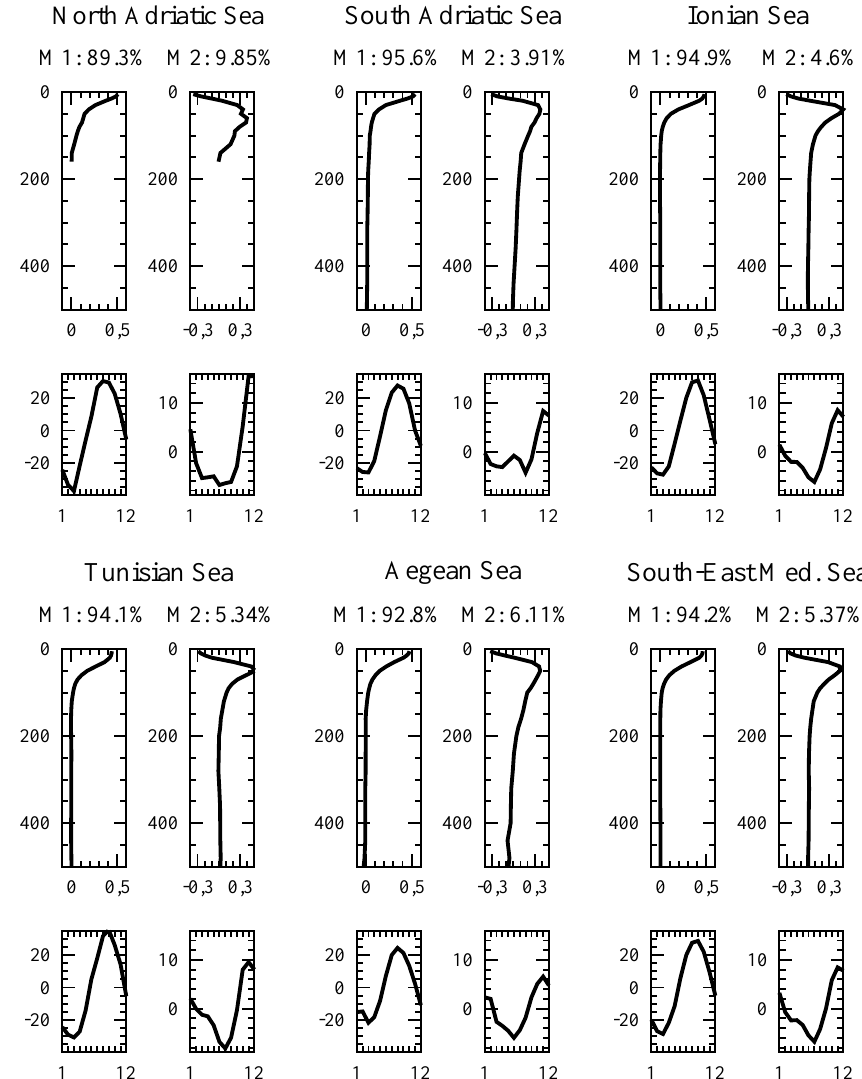
Fig. 14. East Mediterranean: eigenfunctions F 1 (z) and F 2 (z) (m/s) between 5 and 500m, and the associated coefficients α 1 (t) and α 2 (t)